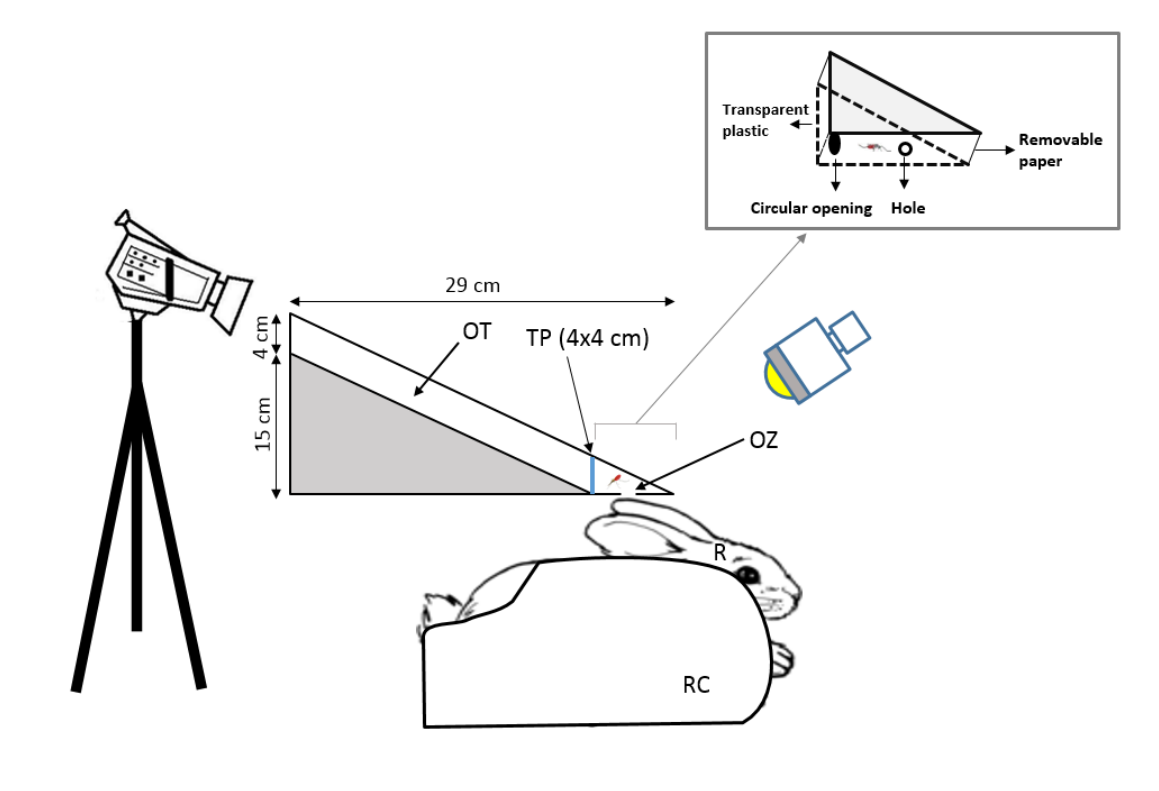
Figure 1. Experimental set-up to monitor the biting behavioural sequence. OT: Observational tunnel, TP: Transparent plastic, OZ: Observational zone (mosquito biting the rabbit ear), R: Rabbit, RC: Restraining cage Feeding success and behavioural